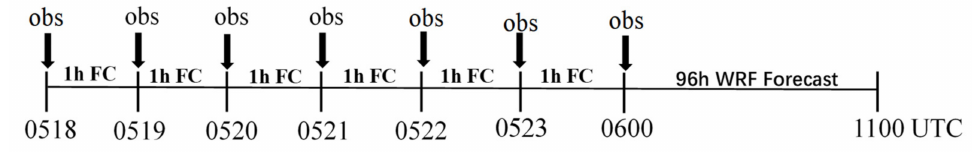
Figure 8. Flow chart of one of the hourly partially cycling data assimilation runs. FC: Forecast.